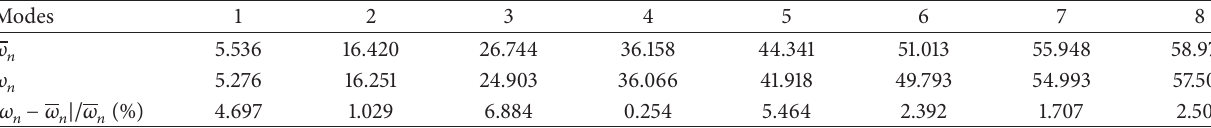
Table 1: Comparison of the natural frequencies before and after